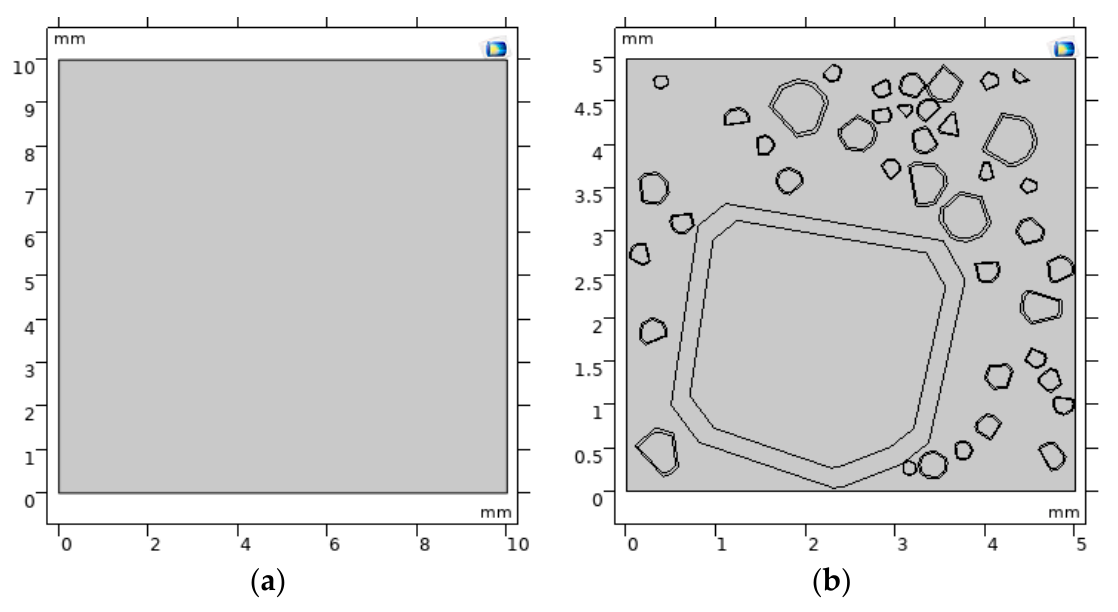
Figure 3. L-UHPC model for LWA particle size of 0.15–4.75 mm. ( a ) Global model; ( b ) random aggregate model. Table 6. Groups of global model parameters.